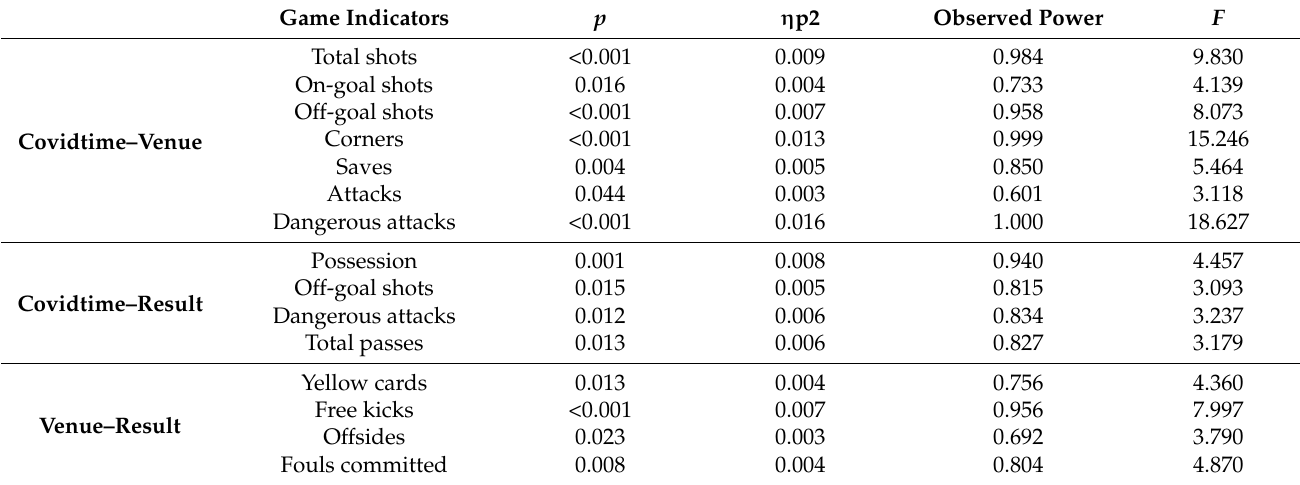
Table 5. Inferential results of the independent variables and game indicators.